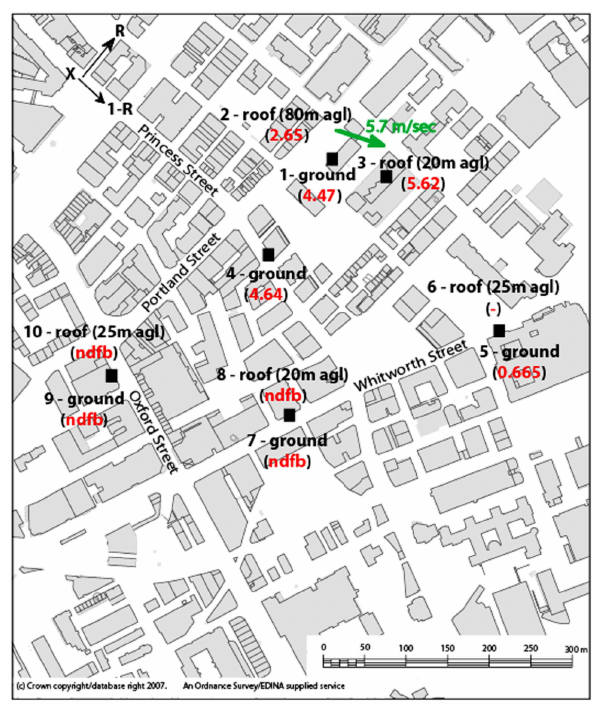
Figure 1. First Cityflux perfluorocarbon tracer experiment including release position (X) and sampling locations (1-10) showing height above ground level and results obtained (concentration/release rate). “ndfb” = non-discernable from background, “-“ = failed sample. Average wind conditions during the experiment at Portland Tower (5.7 m sec -1 , 293° from North ) are shown in green.